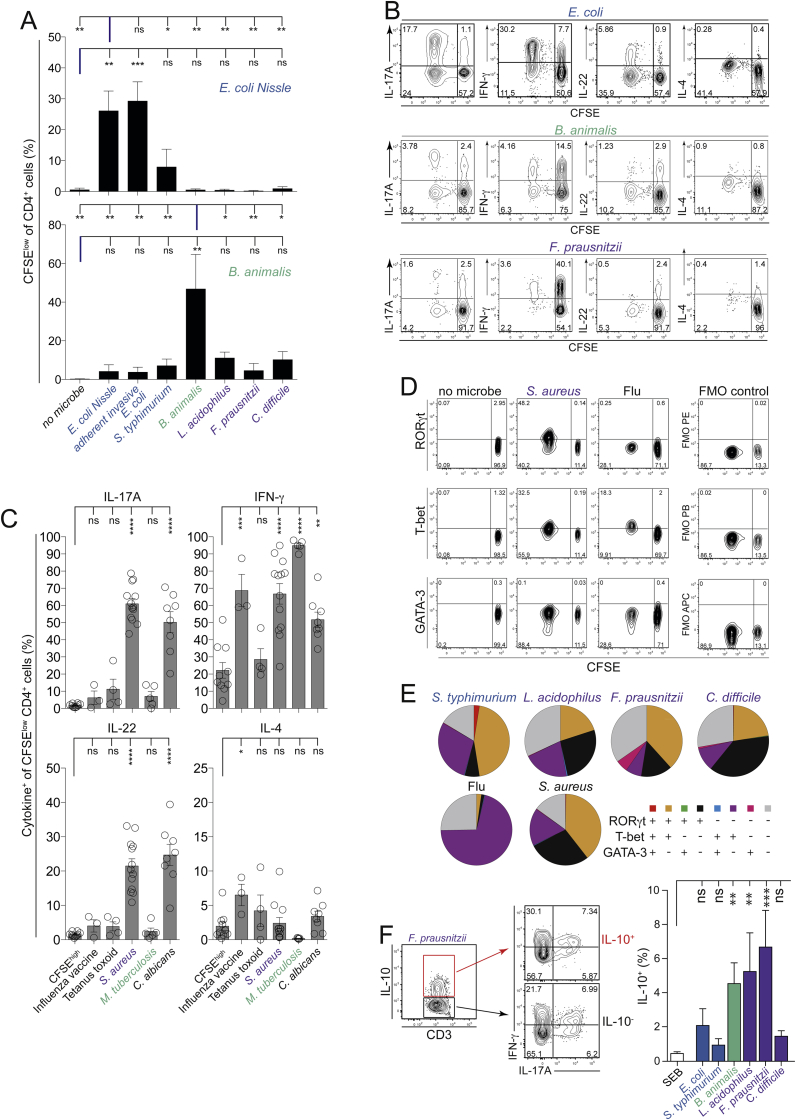
Cross-reactivity, cytokine production, and transcription factor expression by antigen-reactive memory CD4+ T cells (related to Figure 5). (A) CD154+ memory CD4 T cells from PBMCs were sorted after short-term stimulation with E coli and B animalis lysates and expanded them for 10−14 days with CD3/CD28 and IL2. The E coli Nissle- and B animalis−reactive T cell lines were CFSE-labeled and then co-incubated with autologous monocytes loaded with the various bacterial lysates. Frequencies (±SEM) of CFSElow proliferating cells after 5 days of stimulation with the indicated bacteria are shown. Data from 3−6 independent donors. (B−F) Total memory CD4+ T cells were isolated, labeled with CFSE and cultured with autologous irradiated monocytes in the presence of the indicated heat-inactivated bacteria or antigens. (B, C) Production of cytokines by proliferating CFSElow cells measured by intracellular staining after phorbol myristate acetate (PMA)/ionomycin stimulation on day 7 of primary stimulation with monocytes and heat-inactivated bacteria. Frequencies (±SEM) of 3−13 independent donors are depicted. Each dot represents an independent donor. (D, E) Related orphan receptor γt (RORγt), T-box expressed in T cells (T-bet), and GATA-binding factor-3 (GATA-3) expression on day 7 of primary stimulation with monocytes and influenza seasonal vaccination or heat-inactivated S aureus in a representative donor. (E) Boolean gating analysis showing each possible combination of RORγt, T-bet, and GATA-3 production by CFSElow proliferating cells. Data generated from 3 independent donors. (F) Production of IL10 by expanded CFSElow CD4+ cells after PMA/ionomycin stimulation. Frequencies (±SEM) and IFN-gamma/IL17A co-expression within IL10+ and IL10− cells are depicted from 5−8 independent donors. Statistics: (A, C) 1-way analysis of variance with Sidak’s multiple comparison test; (F) Kruskal-Wallis test with Dunn’s multiple comparison; ns, not significant; ∗∗∗P ≤ .001; ∗∗∗∗P ≤ .0001.